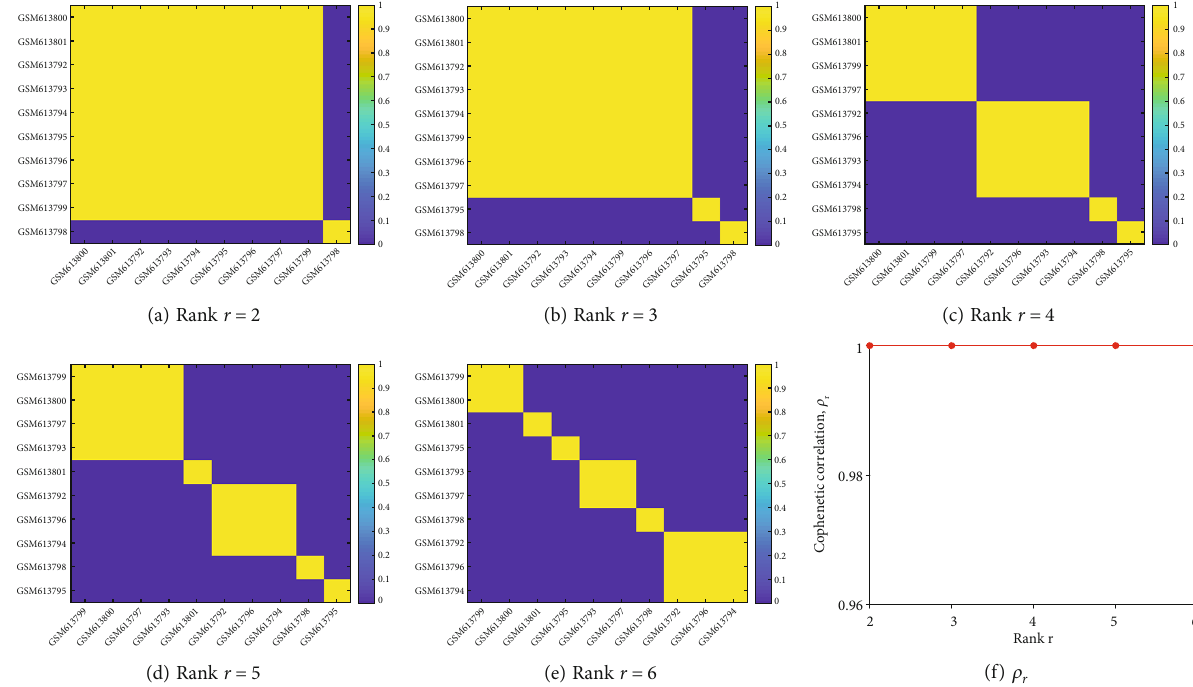
r = 2 ‐ 6 using MM. r for